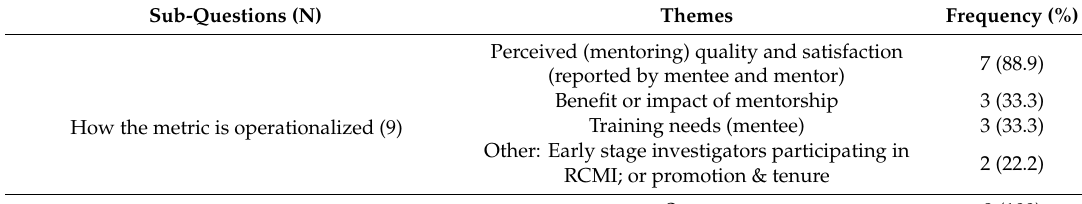
Table 5. Primary Target: Foster professional growth of underrepresented investigators. Key findings of the case study regarding the operationalization and data collection strategies for the metric “mentoring quality”.